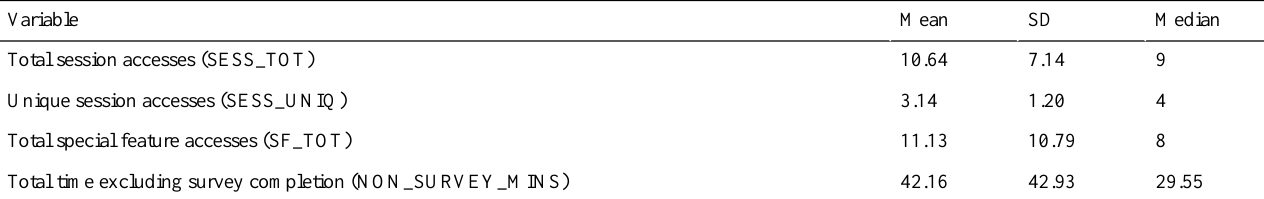
Table 2. Descriptive statistics on component engagement measures (n=2513)